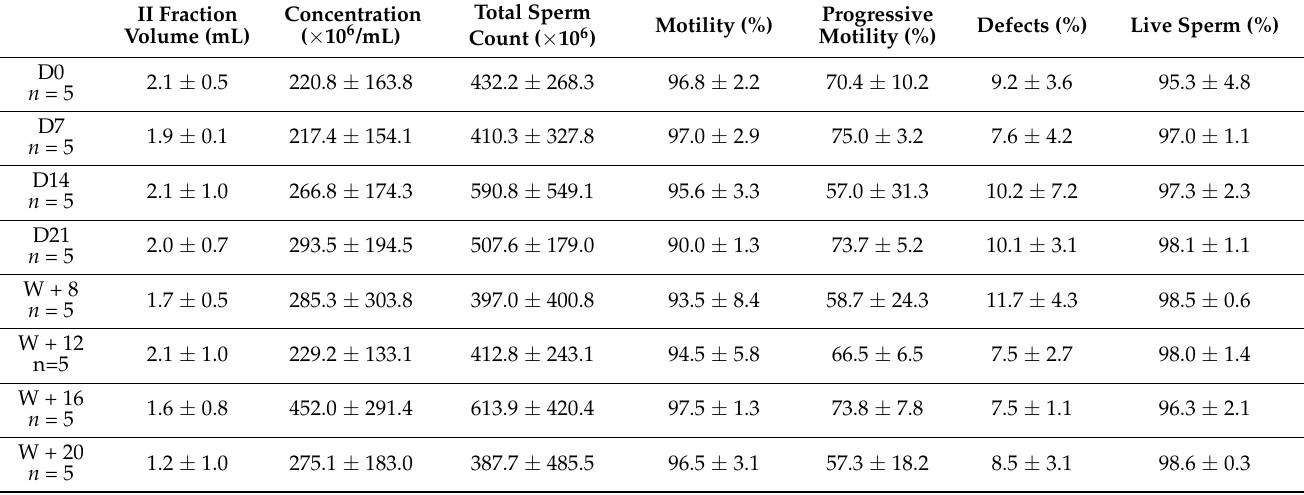
Table 1. Values of qualitative and quantitative parameters of the II sperm fraction samples collected from dogs in control group I (negative control- healthy stud dogs) compared to the results from day 0 ( n = 5). Results are presented as mean ±